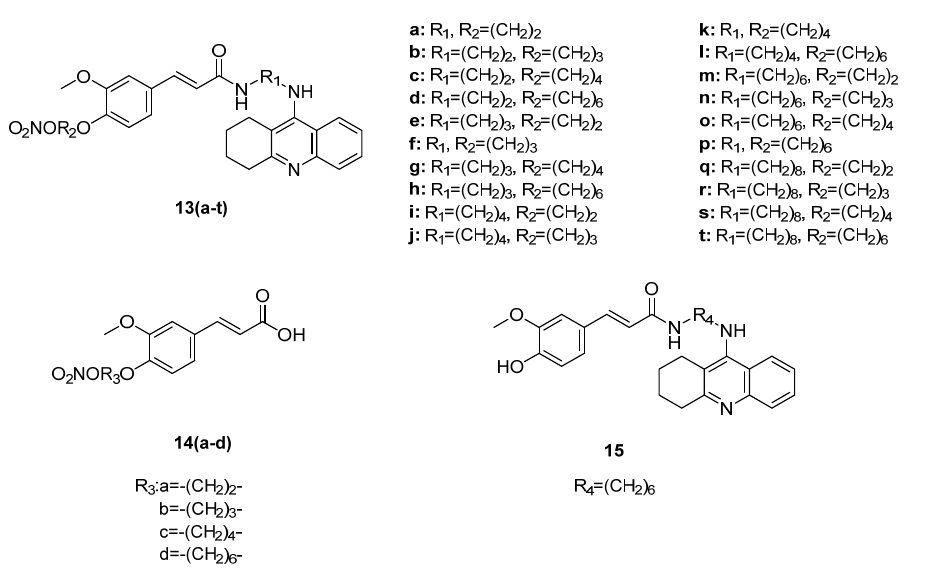
Figure 5. Chemical structure of cinnamic hybrids 13 , 14 and 15 as acetyl- and butyrylcholinesterase inhibitors [44].